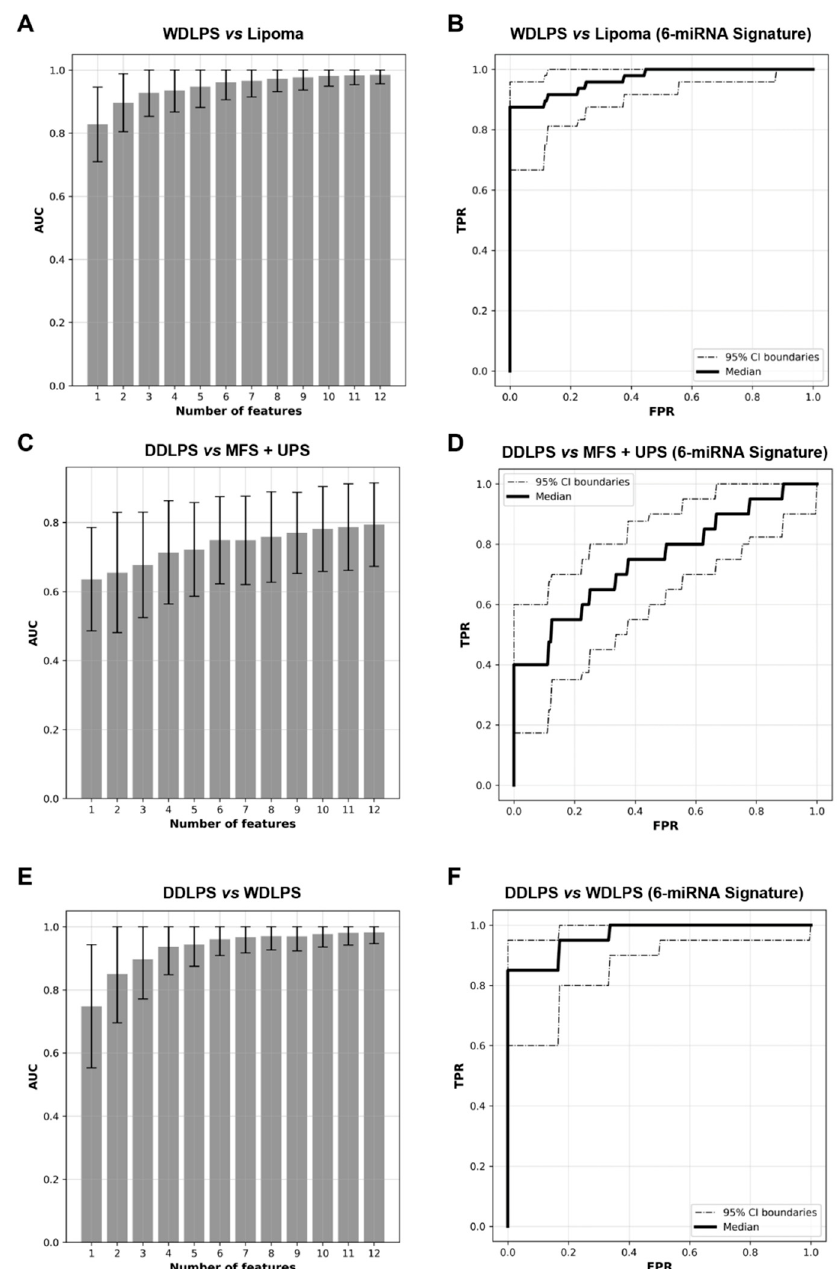
Figure 4. Accurate classification of soft tissue tumors using miRNA signatures. ( A , C , E ) Mean AUC (Area under the ROC curve) of miRNA signatures, with panels of 1 to 12 miRNAs, evaluated for accuracy in differentiating ( A ) WDLPS from lipoma, ( C ) DDLPS from MFS and UPS, ( E ) DDLPS from WDLPS. ( B , D , F ) ROC curves of the optimal miRNA panels evaluated for classifying ( B ) WDLPS from lipoma, ( D ) DDLPS from MFS and UPS, and ( E ) DDLPS from WDLPS.